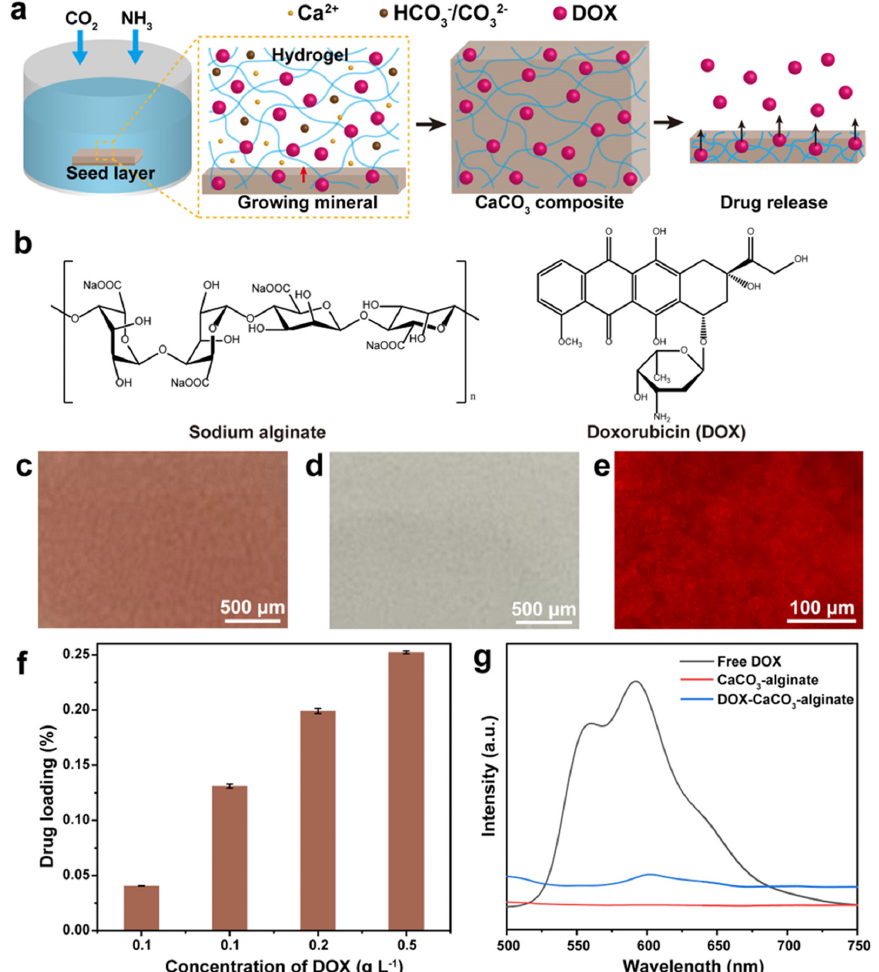
Figure 1. ( a ) Scheme of the seeded mineralization deployed for the formation of the DOX-CaCO 3 - alginate composite. ( b ) Molecular formulae of sodium alginate and DOX. ( c , d ) Digital photos of DOX-CaCO 3 -alginate ( c ) and CaCO 3 -alginate ( d ) films. ( e ) Fluorescence optical microscopic image (green fluorescence with a wavelength of 515–560 nm was used for excitation) of the DOX-CaCO 3 - alginate film. ( f ) Correlations between the concentration of DOX in the reacting mother liquors and the drug occlusion levels, where all measurements and calculations were based on the UV-vis spec- tra and the Beer–Lambert law. ( g ) Steady state photoluminescent spectra (excitation wavelength = 450 nm) of DOX solution, a CaCO 3 -alginate film, and a DOX-CaCO 3 -alginate film. Cross-sectional scanning electron microscopy (SEM) was employed to disclose the microstructural characteristics of the prismatic DOX-CaCO 3 -alginate overlayers (Figure 2a,b). The overlayer is composed of rhombohedral structural units, where the typical {104} facets are disclosed and observable. The surface of these rhombohedra is not smooth but is highly roughened, which is ascribed to the presence of soluble silk fibroin additives and hydrogel matrices in the course of mineralization. The occurrence of scattered nanofibrils in the overlayer should be attributed to the occluded hydrogel matrices. The rhombohe- dral structural feature of the DOX-CaCO 3 -alginate mineral was in line with that of its CaCO 3 counterpart synthesized in DOX’s absence. This result is different from a previous study, which reported that DOX—as a soluble additive—had a direct impact on the mor- phological control of DOX-CaCO 3 precipitates [13]. Therefore, it was assumed that in the